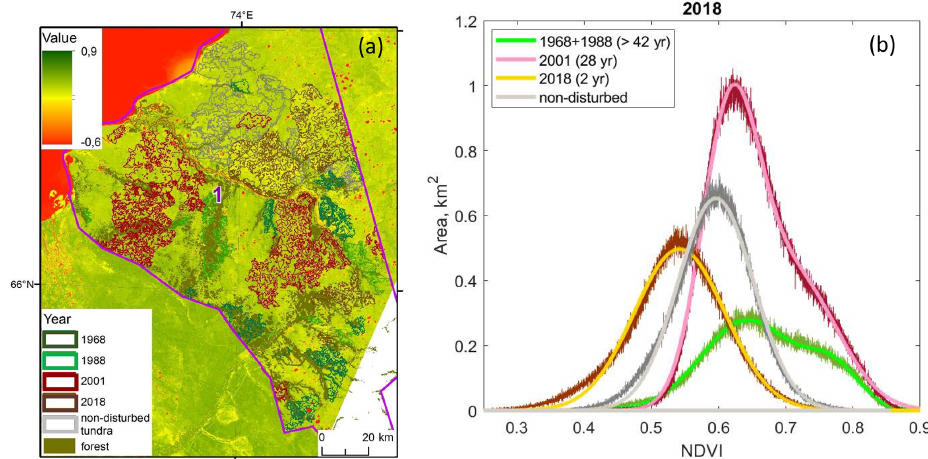
Figure 7. (a) The distribution of NDVI over study area 1 on 30 June 2018. Segments with boundaries of different color are non-disturbed dry tundra sites and burned dry tundra sites detected in Corona and Landsat mosaics from different years (see legend). Burned areas in the mosaics from 1968 and 1988 are mainly due to fires from > 42 years ago, in 2001 they are due to fires from 28 years ago; in 2018 they are due to fires from 2 years ago. (b) Distributions of NDVI based on the data from marked non-disturbed sites and sites burned in different years. In the legend, numbers in parentheses indicate years after the last major fire.